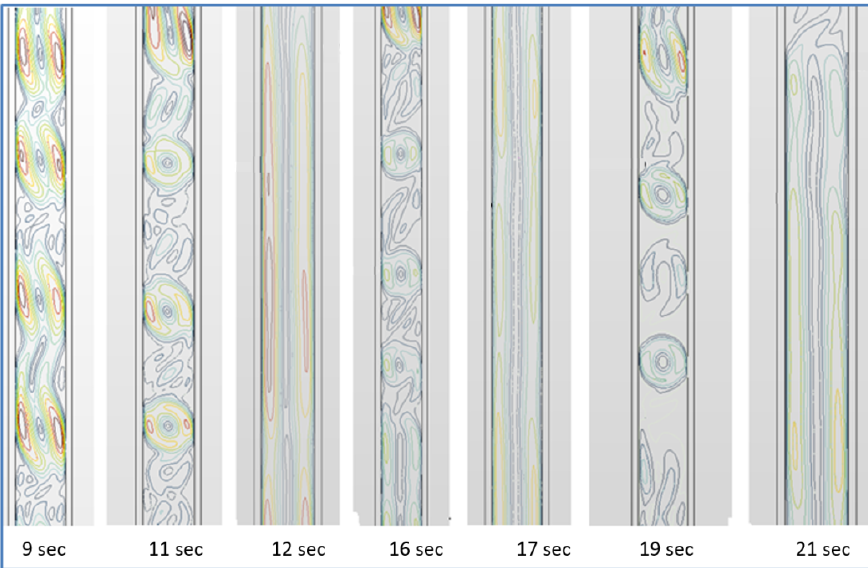
Figure 6. Velocity fields in the channel b = 30 mm as a function of time.